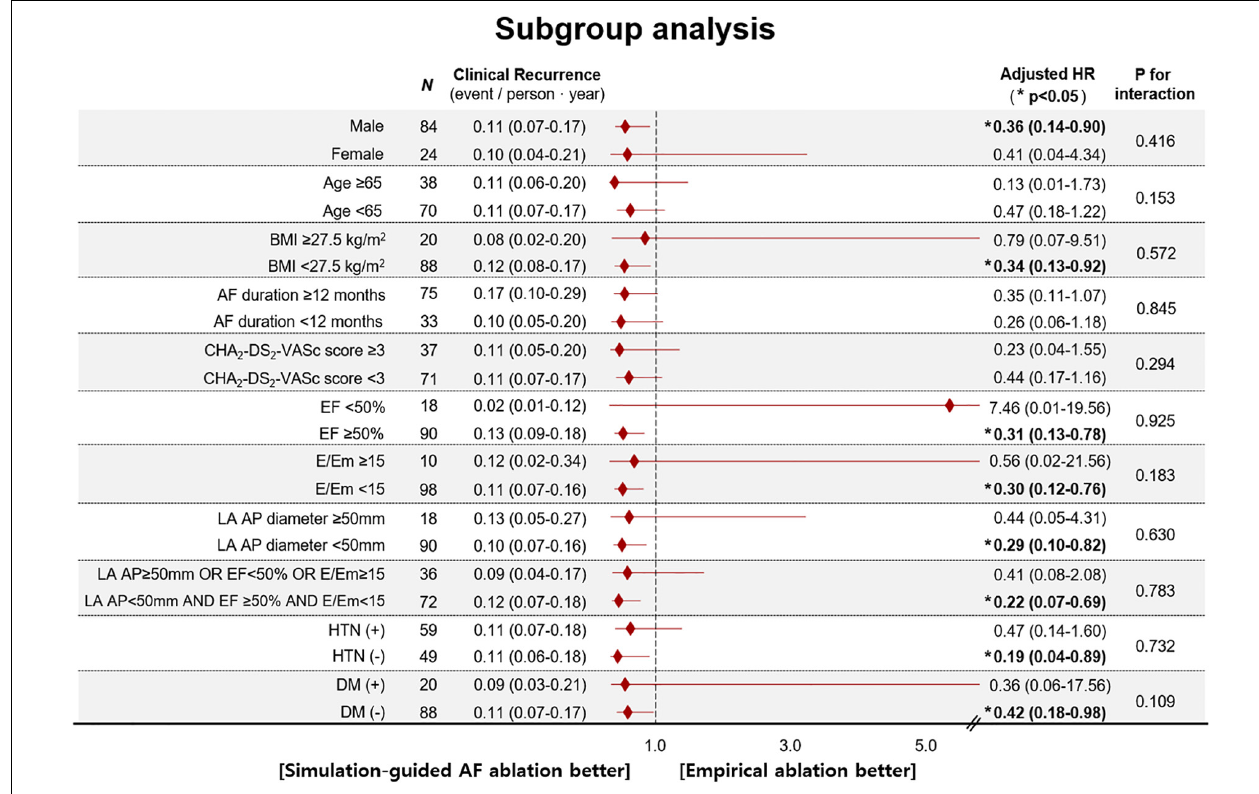
FIGURE 4 | Age- and sex-adjusted HR for post-RFCA clinical recurrence of AF according to subgroups (Cox proportional-hazard model regression analysis). AF, atrial fibrillation; AP diameter, antero-posterior diameter; BMI, body mass index; DM, diabetes mellitus; EF, ejection fraction; E/Em, the ratio of early transmitral flow velocity (E) to early mitral annular velocity (Em); HR, hazard ratio; HTN,